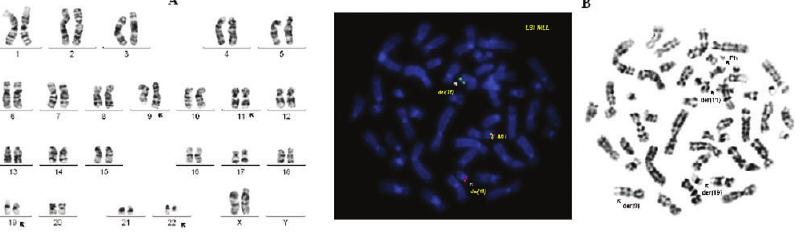
Figure 1. Karyotype of the patient showing simultaneous occurrence of t(9;22)(q34;q11) and t(11;19)(q23;p13.1) (A). FISH using a MLL dual-color, break-apart probe revealing the juxtaposition of the distal part of the MLL gene from chromosome 11 to the der(19) chromosome, adjacent to the centromeric region (red signal)